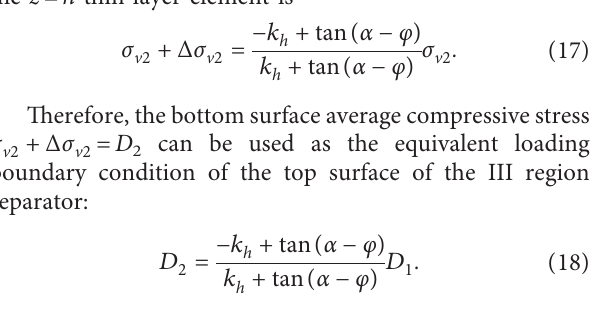
Figure 3: Forces acting on horizontal elements of zone I.